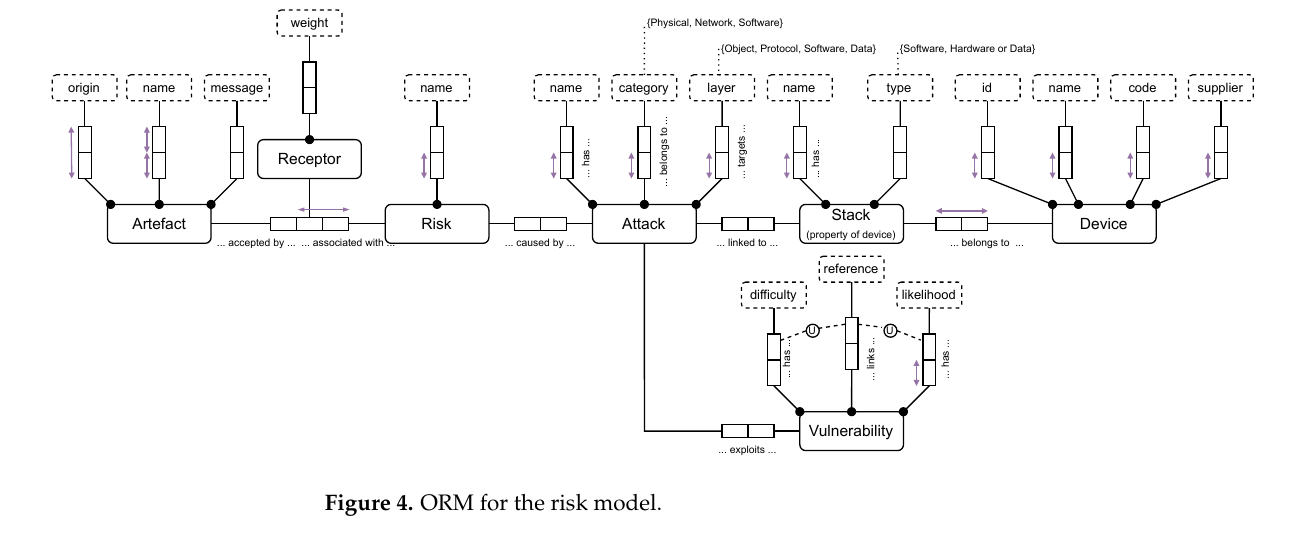
Figure 4. ORM for the risk